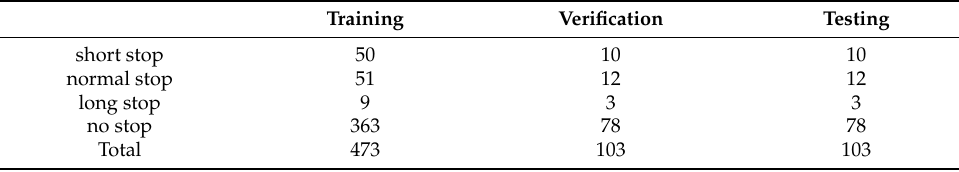
Table 5. Breakdown of the number of data sets for each training.